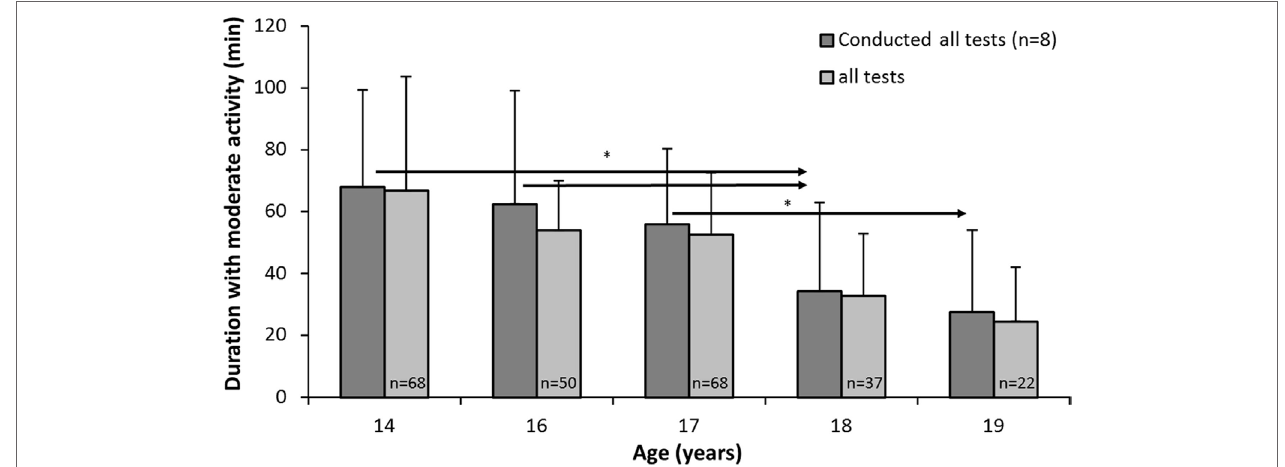
FigUre 1 | Minutes of moderate or vigorous physical activity (PA) (daily) among subjects with valid data on all five tests ( n = 8) and for all subjects tested on each test day. * indicates a significant decrease in PA between these test years and later years at a p < 0.05 level, as indicated by the right-pointing